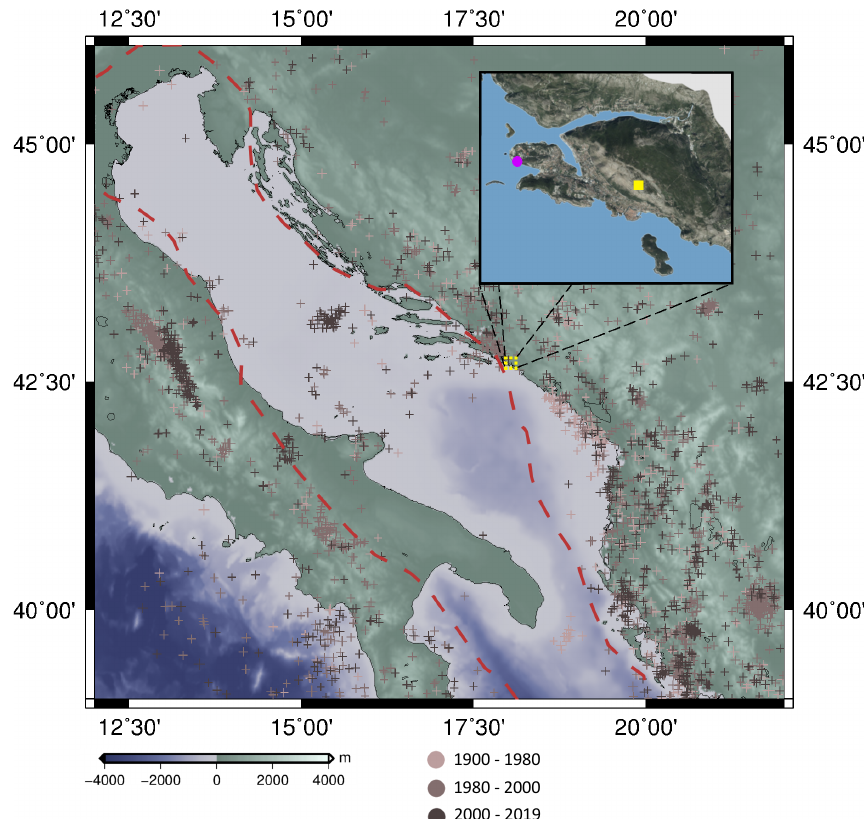
Figure 1. The study area shown in a topographic map (ETOPO1 topography/bathymetry model [36]) related to a broader geographical area showing seismic activities (epicenters of all registered earthquakes of magnitude >4.0 from 1990, shown by ‘+’; data downloaded from [25]) and known plate tectonics (border of the Adriatic tectonic plate shown in red; according to [37]); pink circle represents the tide gauge station whereas yellow square shows collocated GNSS